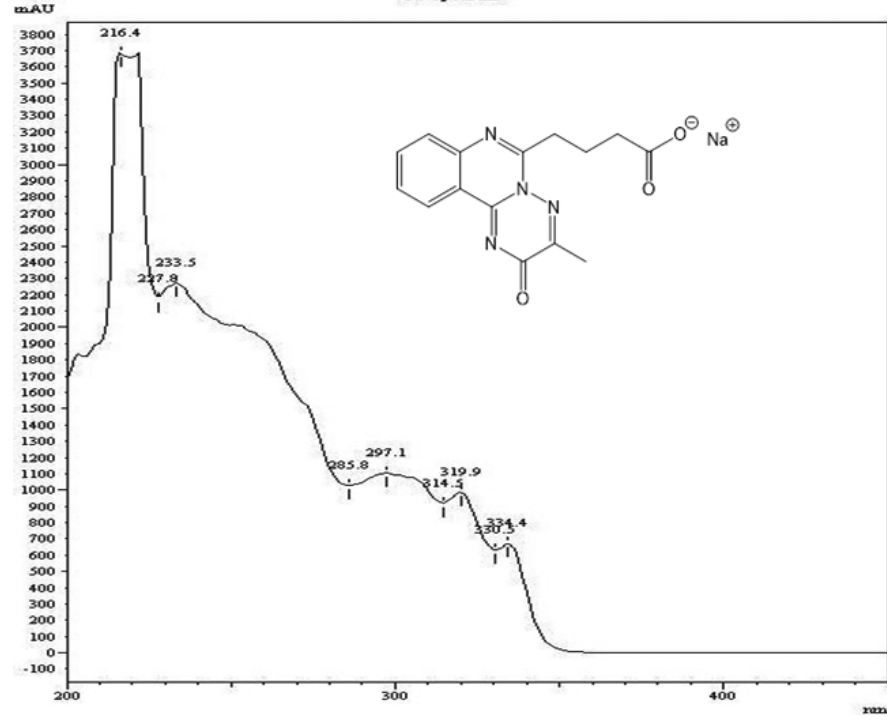
Figure 2. UV spectrum of